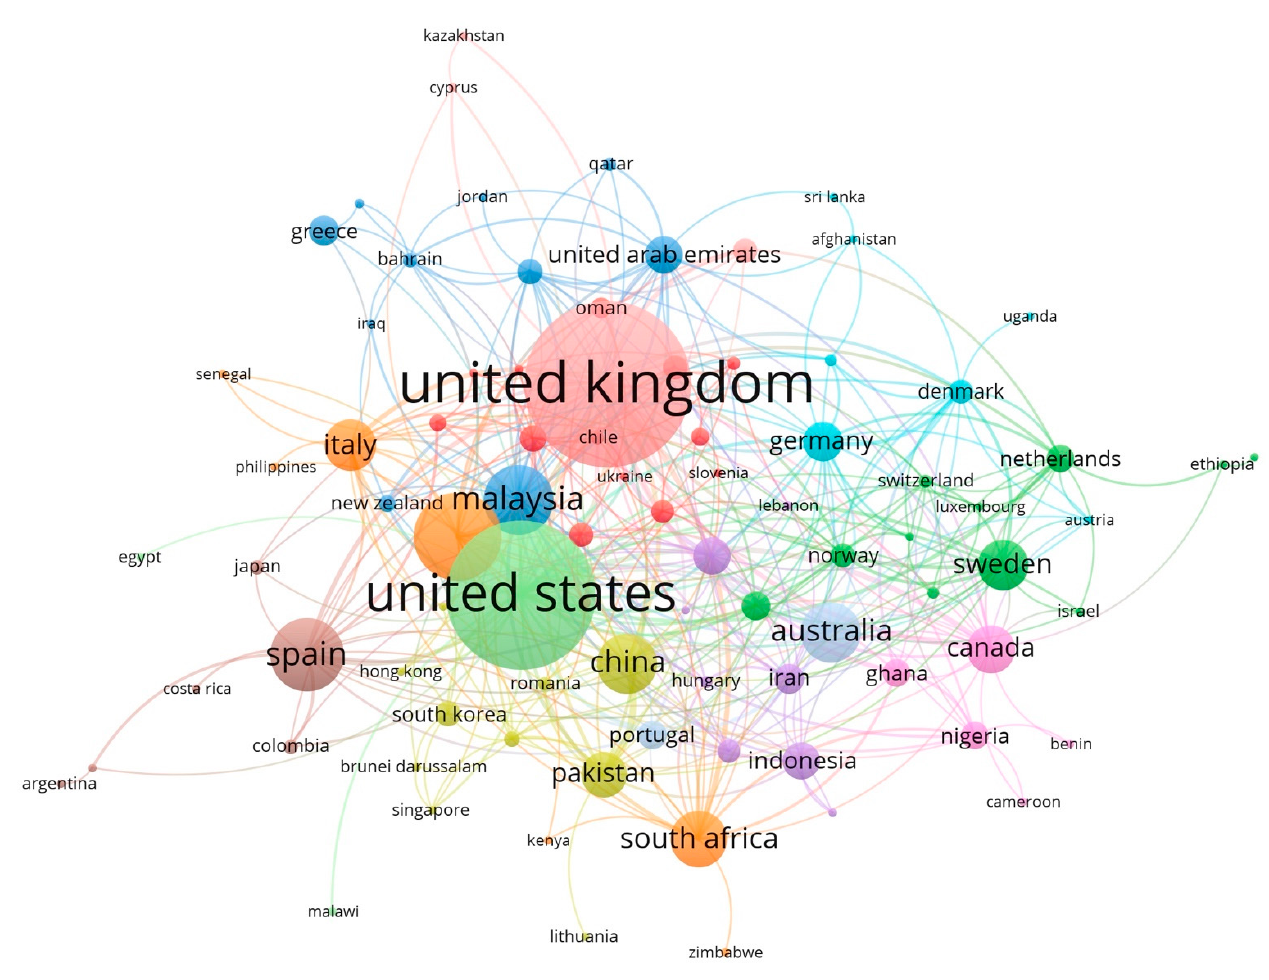
Figure 9. Countries co-occurrence map .